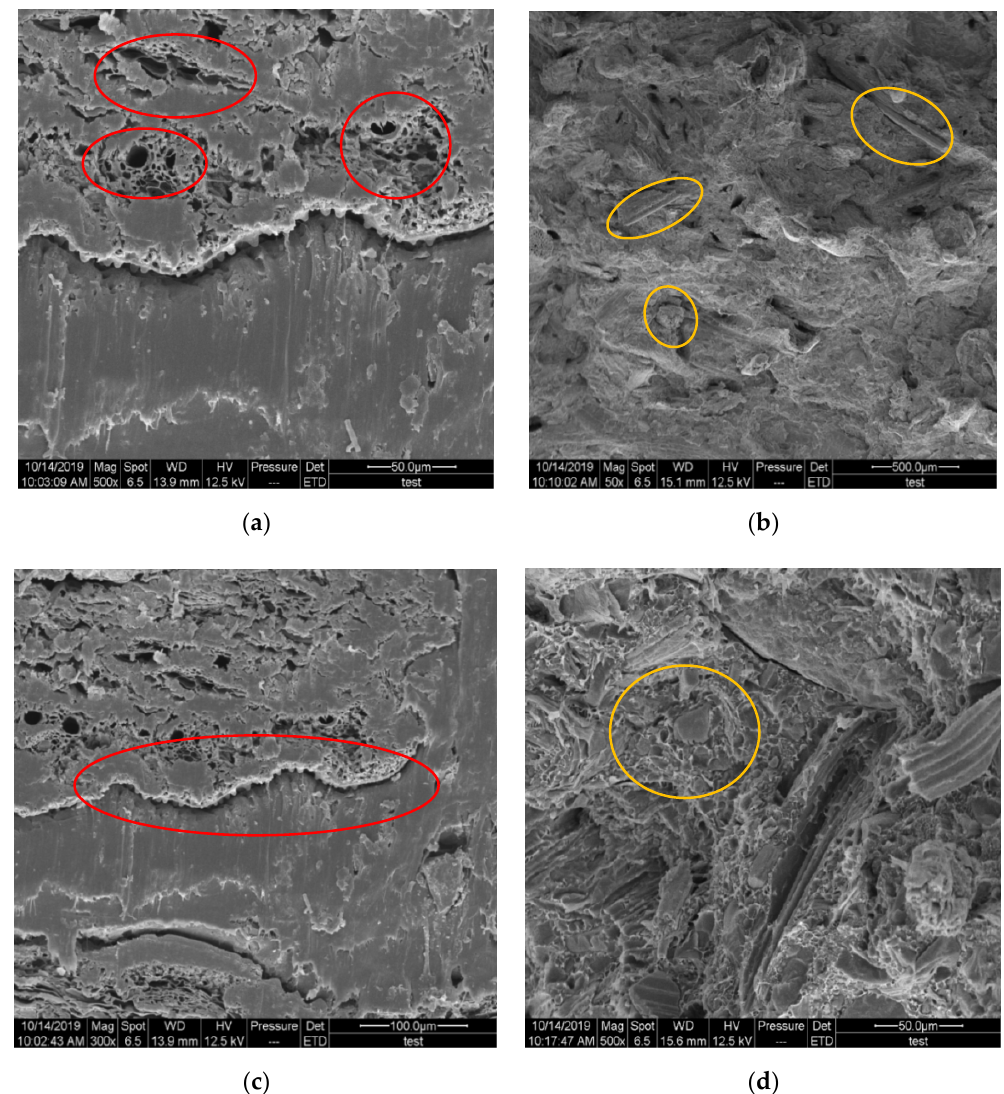
Figure 6. Microscopic morphology of the fracture surface of hot pressed ( a , c ) and extruded ( b , d ) straw/LLDPE composite.